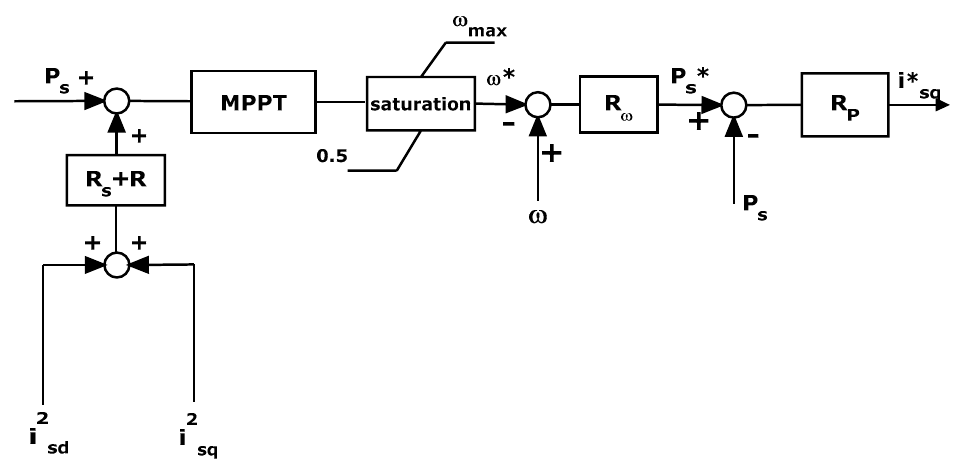
Figure 7. Correction in the power controller block diagram (Type II).